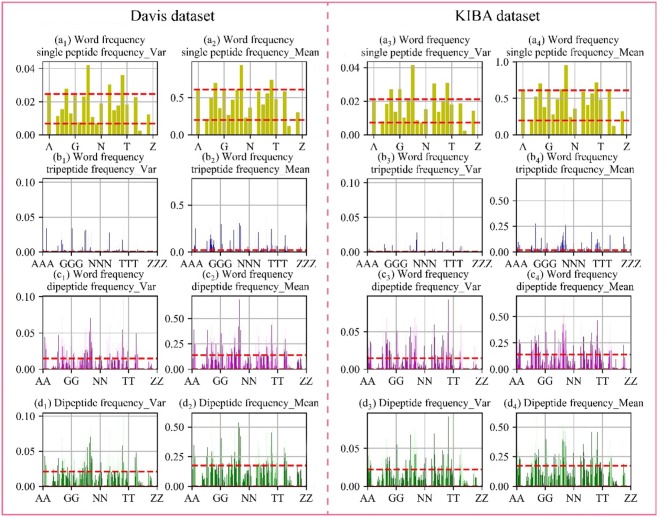
Frequency chart of word frequency peptides. The X-axis is the peptide amino acid combination, and the Y-axis is the word frequency polypeptide frequency score. (a) Are the scores of the single peptide frequency of word frequency, (b) are the scores of the tripeptide frequency of word frequency, (c) are the scores of the dipeptide frequency of word frequency, and (d) are the scores of the dipeptide frequency. The red lines represent the upper and lower quartiles. The first and second columns are the Davis data set, and the first and second columns are the KIBA data set.